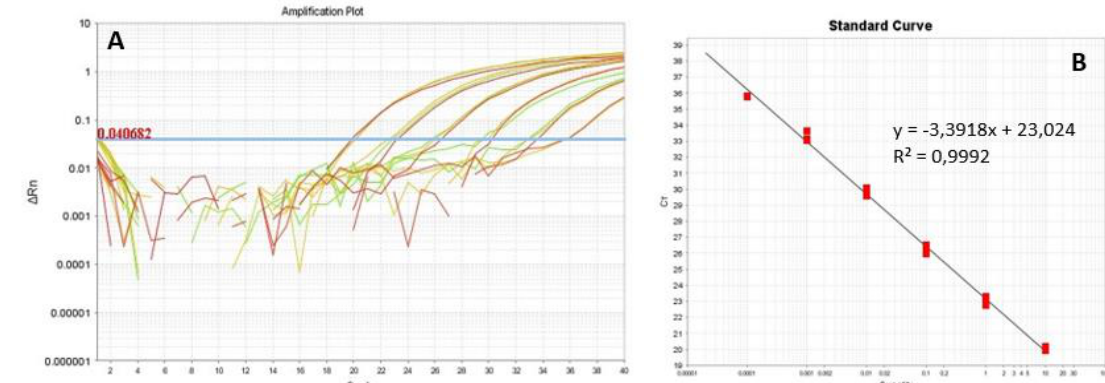
Figure 2. ( A ) Amplification with real-time PCR assay of serial dilutions of DNA of F. fujikuroi I1.3. The threshold cycle values (Ct) of the fungal DNA ten-fold serial dilutions are represented in red and green. ( B ) Regression line obtained. The equation of the line and the coefficient of determination are shown in the graph.